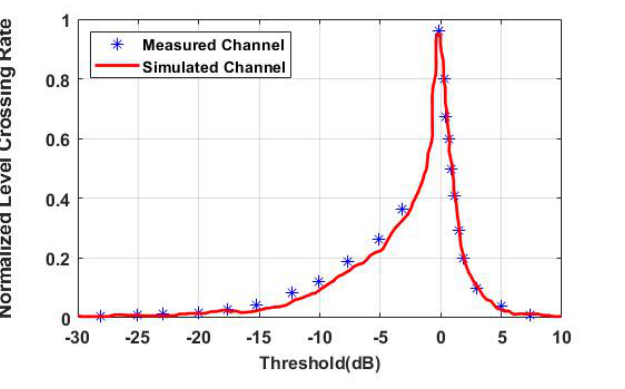
Figure 11. The LCRs of the proposed HST channel model and the measured